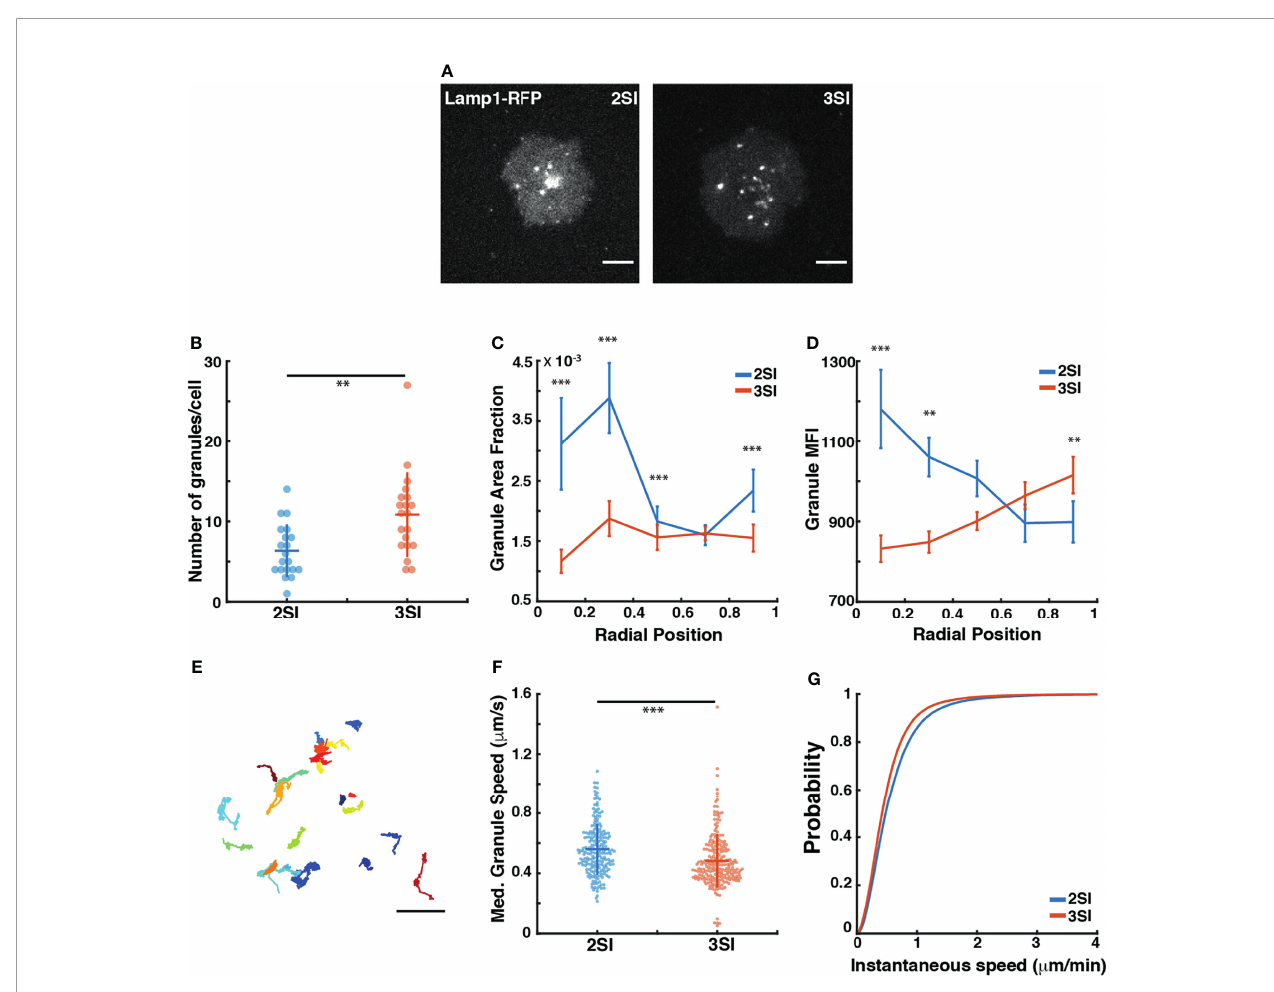
FIGURE 2 | 3SI CTLs exhibit altered lytic granule distribution and dynamics: (A) Representative snapshots of a 2SI and 3SI CTL expressing Lamp1-RFP interacting with an anti-CD3-coated coverslip imaged using TIRF microscopy after reaching maximum spread area. Scale bar = 5 µm. (B) Number of granules for 2SI and 3SI CTLs detected per cell using thresholding. For granule number, p =0.002 (Wilcoxon rank-sum test). (C) Fraction of the complete cell area occupied by lytic granules granules and (D) Granule MFI binned according to granule radial position. Data is presented as mean ± SEM. (E) Full lytic tracks for a representative 3SI CTL. Scale bar = 2 µm. (F) Median granule speeds and (G) cumulative distribution function of instantaneous granule speeds obtained from tracking of lytic granules. For median granule speeds, p=6.762793e-08 (Wilcoxon rank-sum test). For instantaneous granule speeds, p=0.005 (two-sample Kolmogorov-Smirnov test). Data taken from 20 cells each for 2SI (n=205 tracks) and 3SI (n=226 tracks) from 2 independent experiments. ***p<0.001,